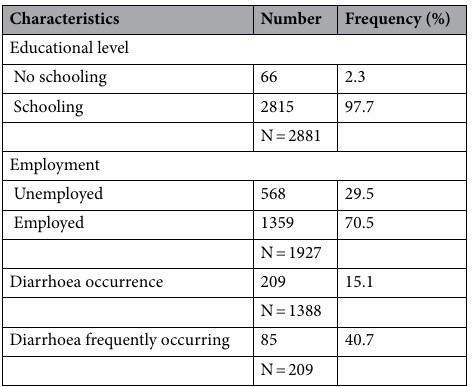
Table 1. Overall demographic information of the Vhembe District